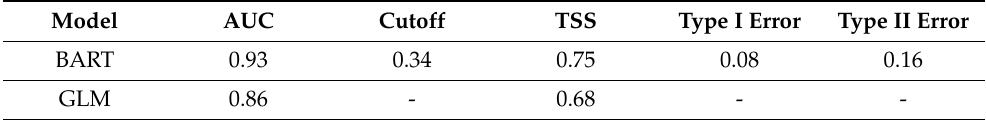
Table 2. Results of the performance evaluation of the models.